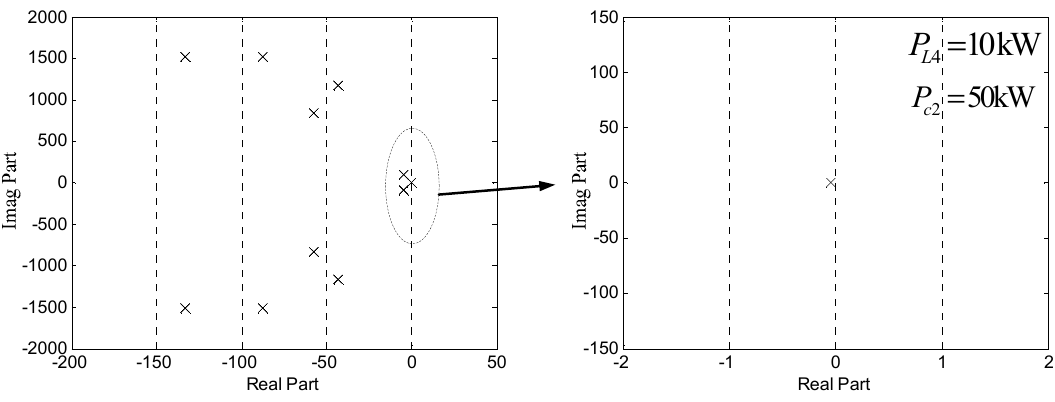
Figure 13. The dominant poles of T m when P L 4 = 10 kW, P c 2 = 50 kW.